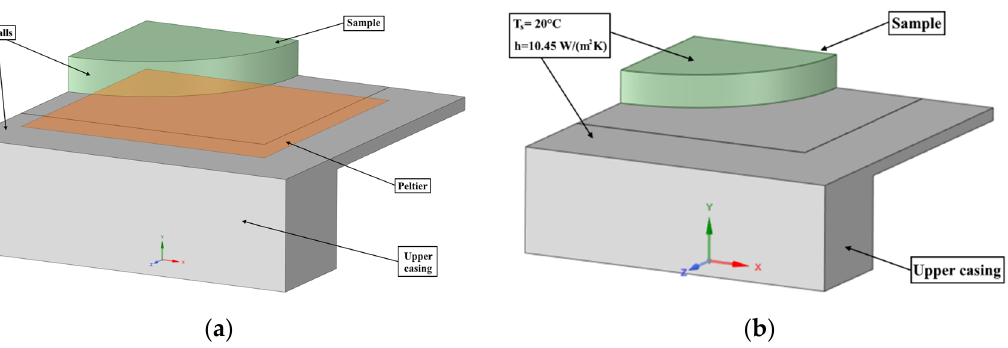
Figure 8. Cooling assembly shown on ( a ) consist of three main elements where the different boundary conditions were prescribed on the surface selections shown on this figure. On figure ( b ) the boundary condition temperature and heat transfer coefficient are given.